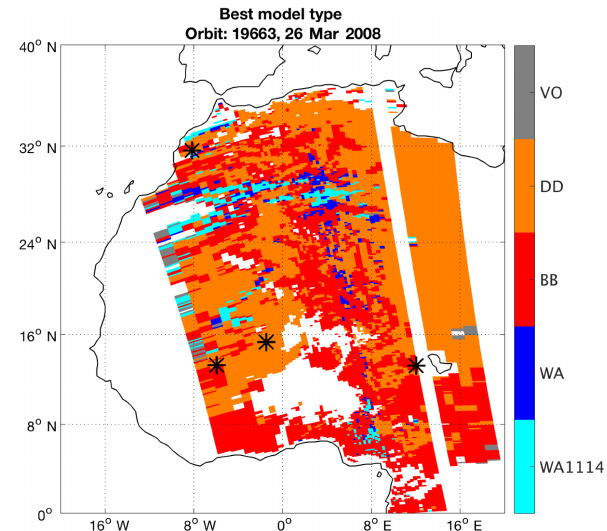
Figure 10. The main aerosol type of the retrieved model with the highest amount of evidence. The locations of AERONET sites Agoufou, DMN_Maine_Soroa, IER_Cinzana and Saada (see Ta- ble 2) are marked by black